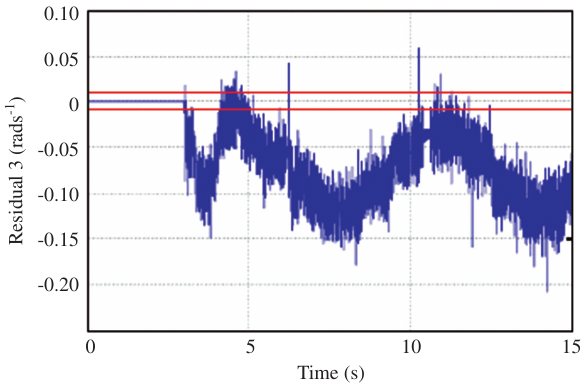
Figure 9. Residual 3 with Defect at t = 3.5 s.